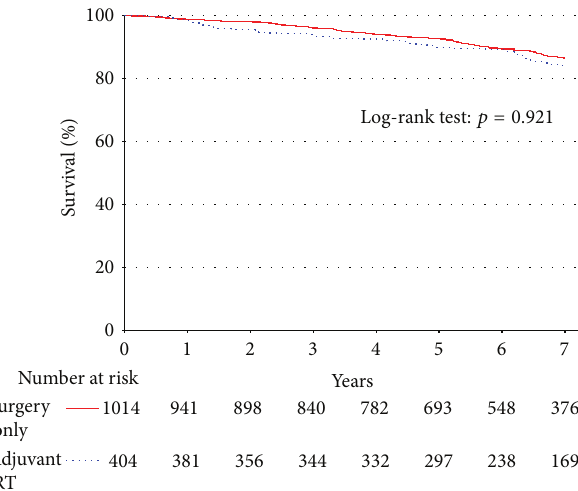
Figure 4: There is no difference in unadjusted survival for patients with well-differentiated liposarcoma when stratified by adjuvant RT versus surgery alone.